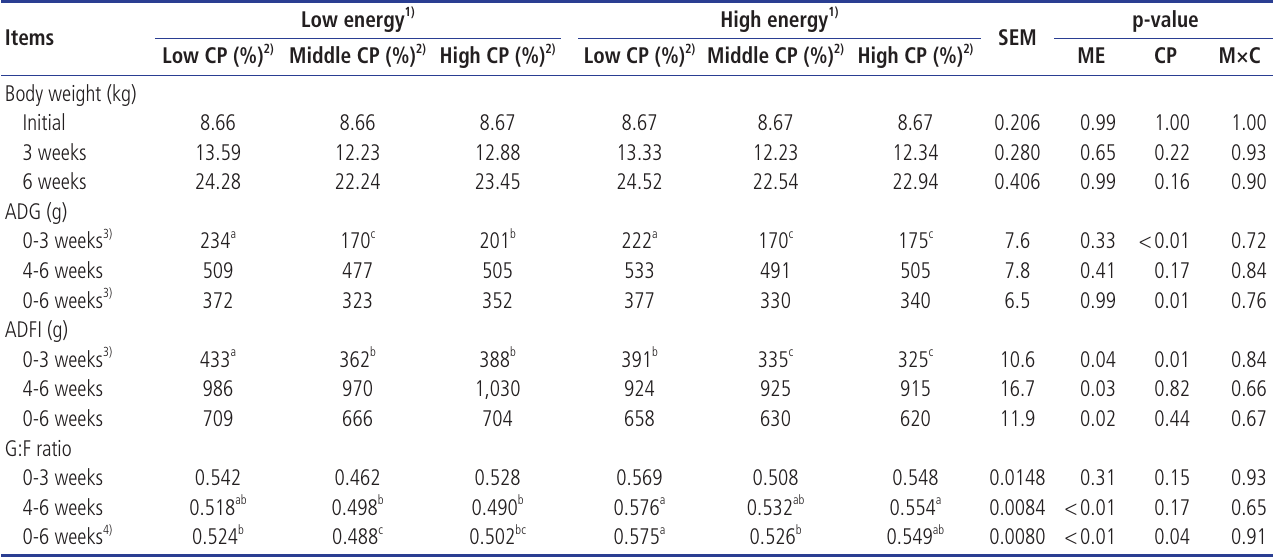
Table 3. Effects of dietary energy and crude protein levels on growth performance in weaning pigs Items